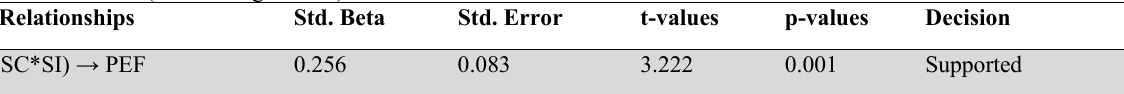
Fig. 4. Interaction Effect of Strategic Innovation (IS) and Structure Capital (SC) on SMEs Performance (PER) Structural Model (Moderating Effects)